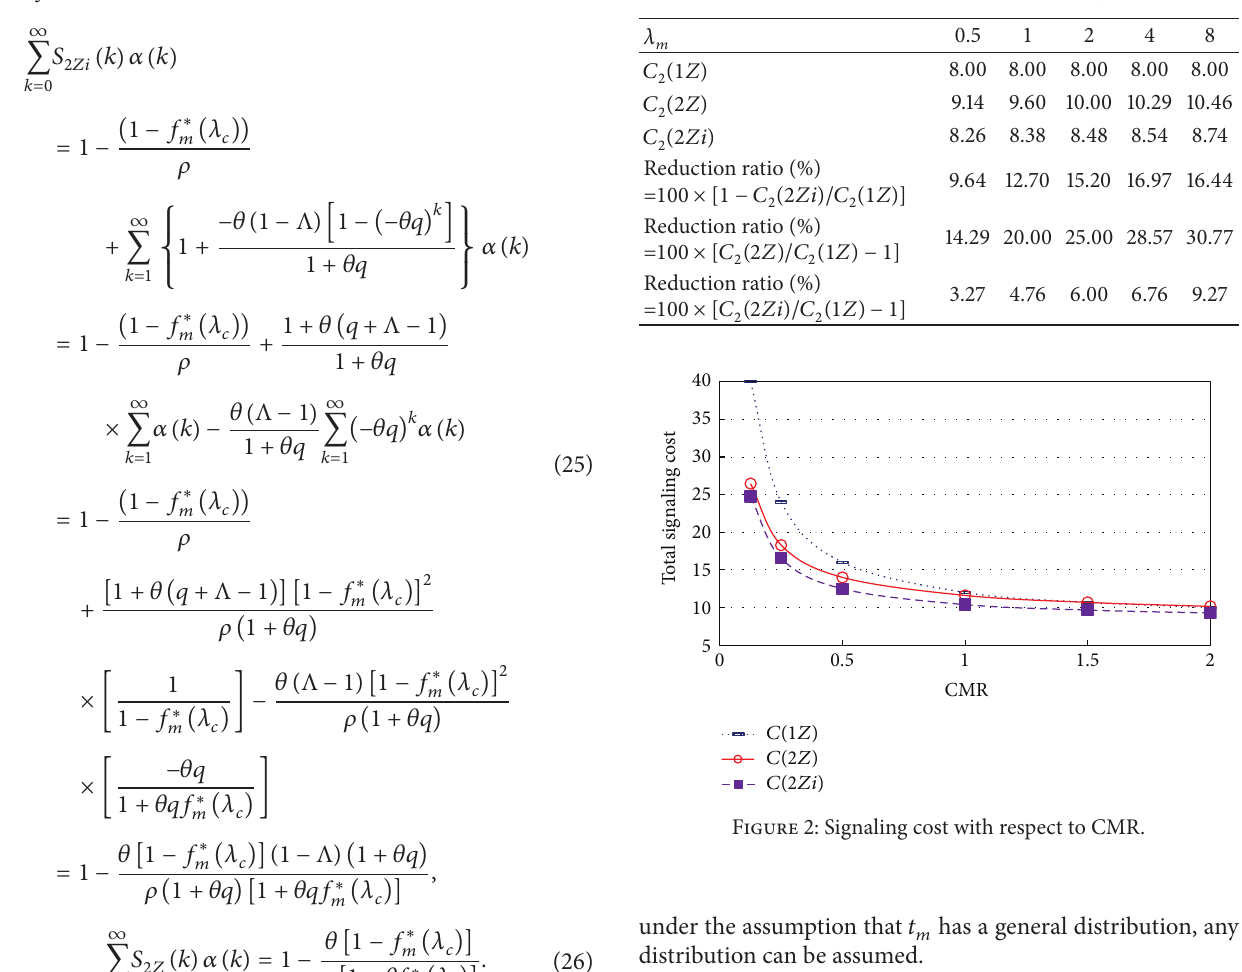
Table 2: Paging cost with respect to 𝜆 𝑚 .